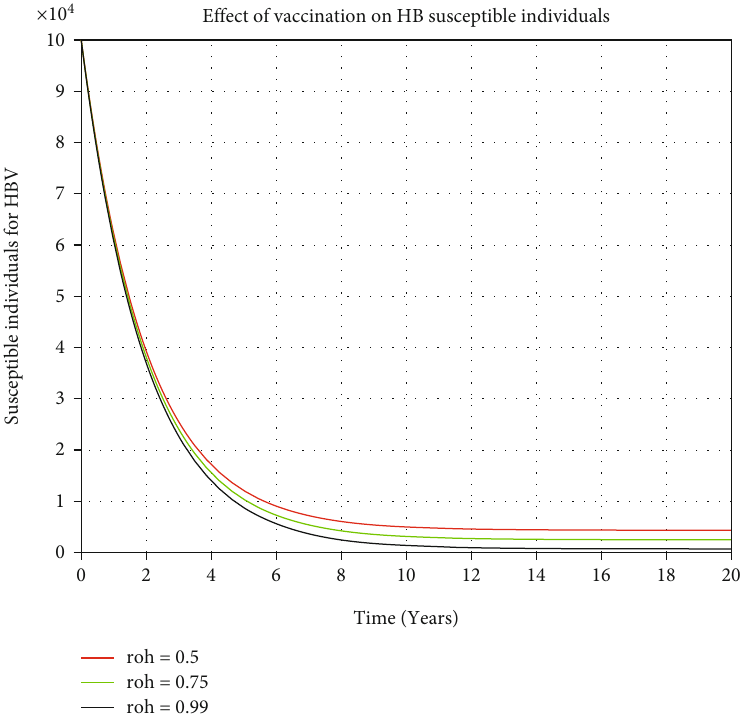
Figure 9: The e ff ect of vaccination on HB susceptible